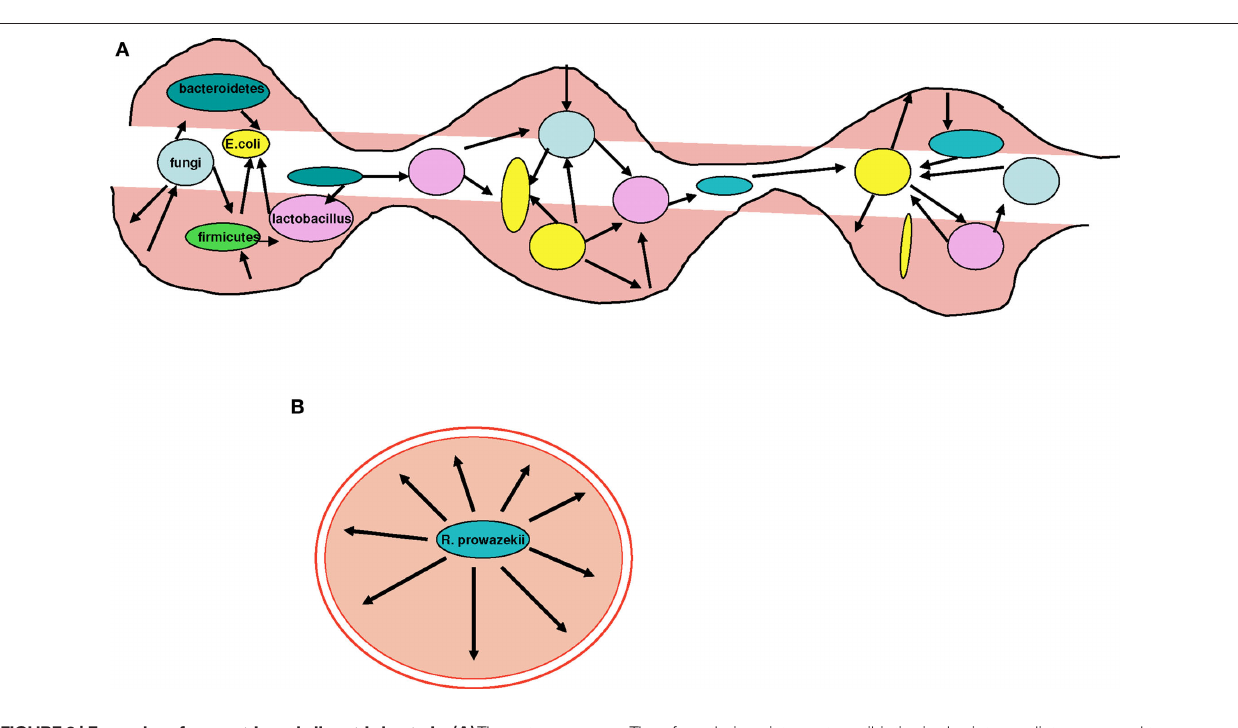
Figure 8 | examples of sympatric and allopatric bacteria. (A) The gut microbiota comprise millions of bacterial species, such as Bacteroidetes , Firmicutes , Lactobacillus , and Escherichia, and fungi. Each of these sympatric species exchanges genes at an intermediate rate, placing them between free-living non-specialized bacteria and isolated obligate intracellular